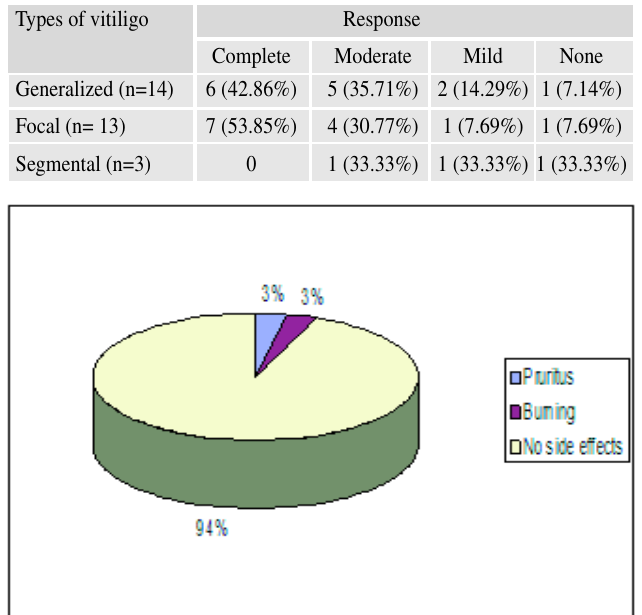
Fig 1. Side effects during therapy in the study